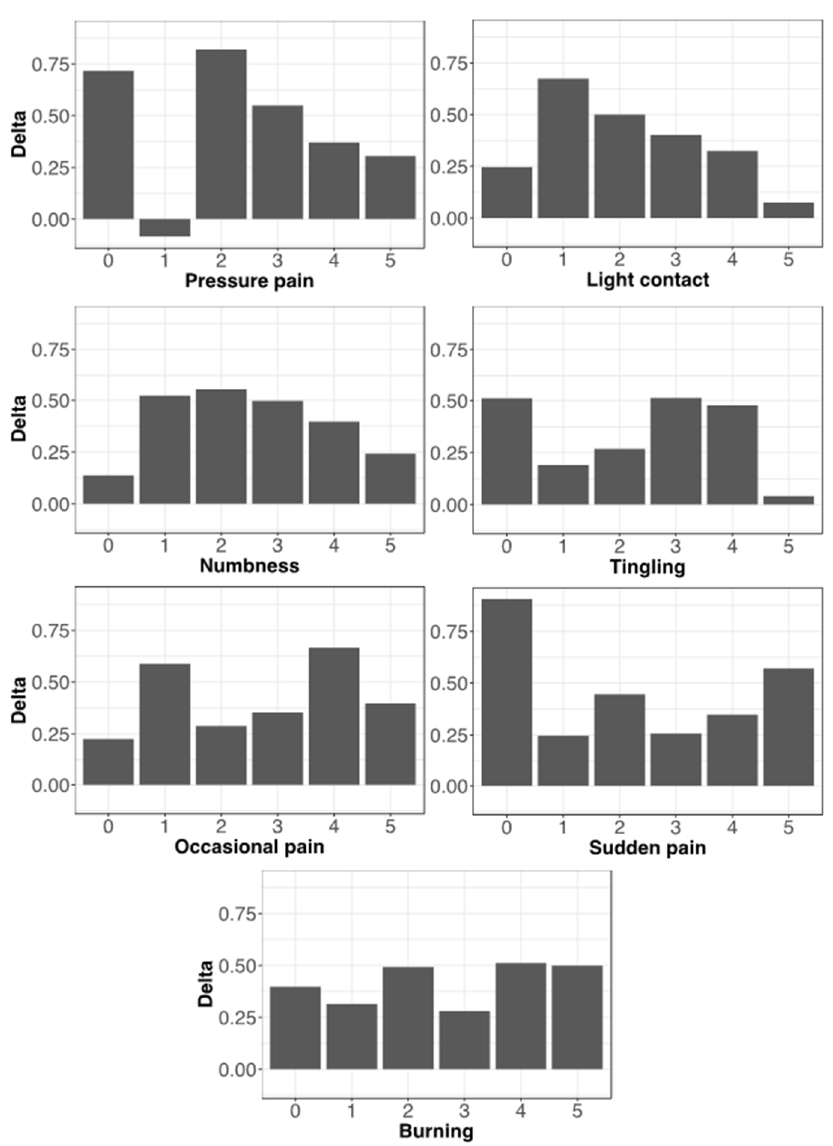
Figure 8. Correlations between treatment effectiveness and pain types. Bars (Delta values) represent differences between the average effectiveness of non-pharmacological and pharmacological therapies for each level of intensity of the different types of pain. Positive values indicate the prevalence of non-pharmacological treatments, which is almost total but tends to decrease with higher values of pain intensity in pressure pain, light contact, numbness, and also in tingling, though with a biphasic trend. The countertrend value at intensity level “1” of pressure pain could represent a random fluctuation due to the limited number of data (n =